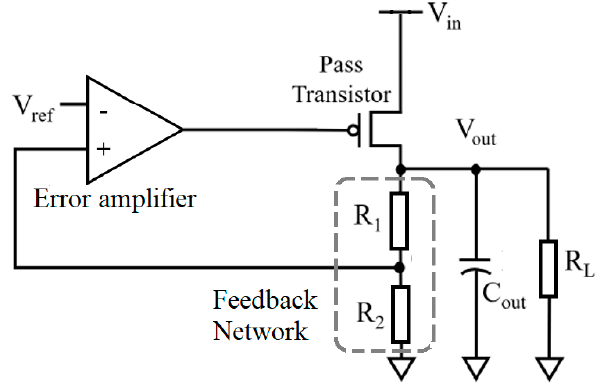
Figure 5. Basic Block Diagram of LDO Voltage Regulator.